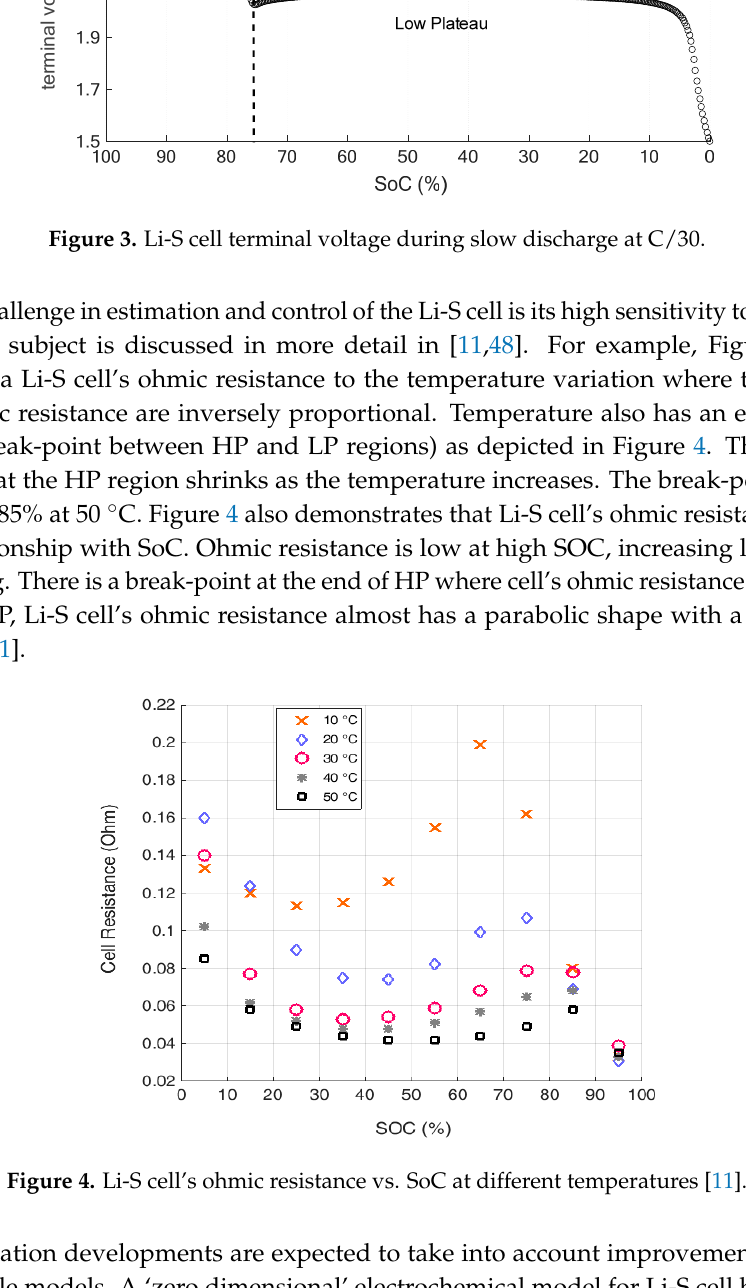
Figure 5. Expected road map for state estimation in Li-S: colors are a ‘traffic light’ indication of technology readiness, with green representing most ready, and red representing furthest off [58]. 4. Current and Future Applications of Li-S Battery Systems designers will use Li-S batteries where the characteristics of the technology are best suited to the application. If we first understand the inherent characteristics, we can then match them to the most suitable markets.